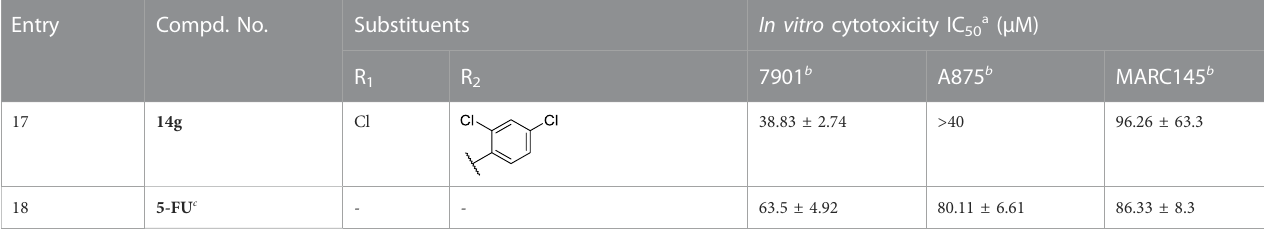
TABLE 1 ( Continued ) In vitro cytotoxic activities of target compounds against tested cell lines. Entry